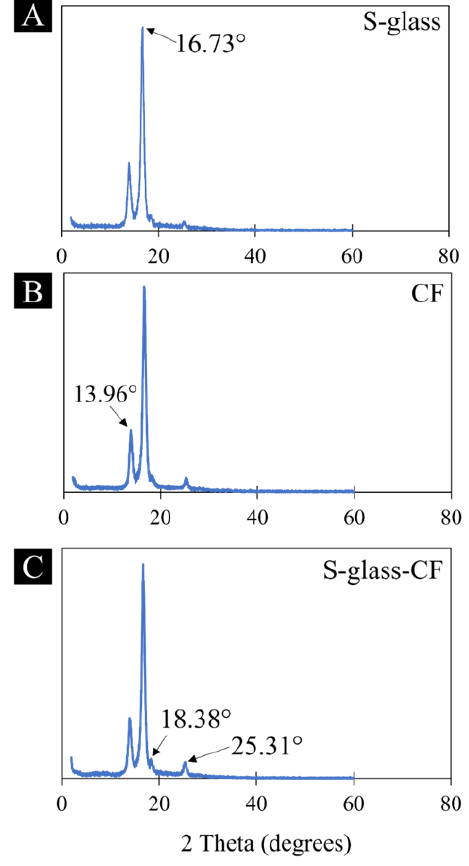
Figure 3. XRD analysis of ( A ) GFRP, ( B ) CFRP, and ( C ) C/GRP.